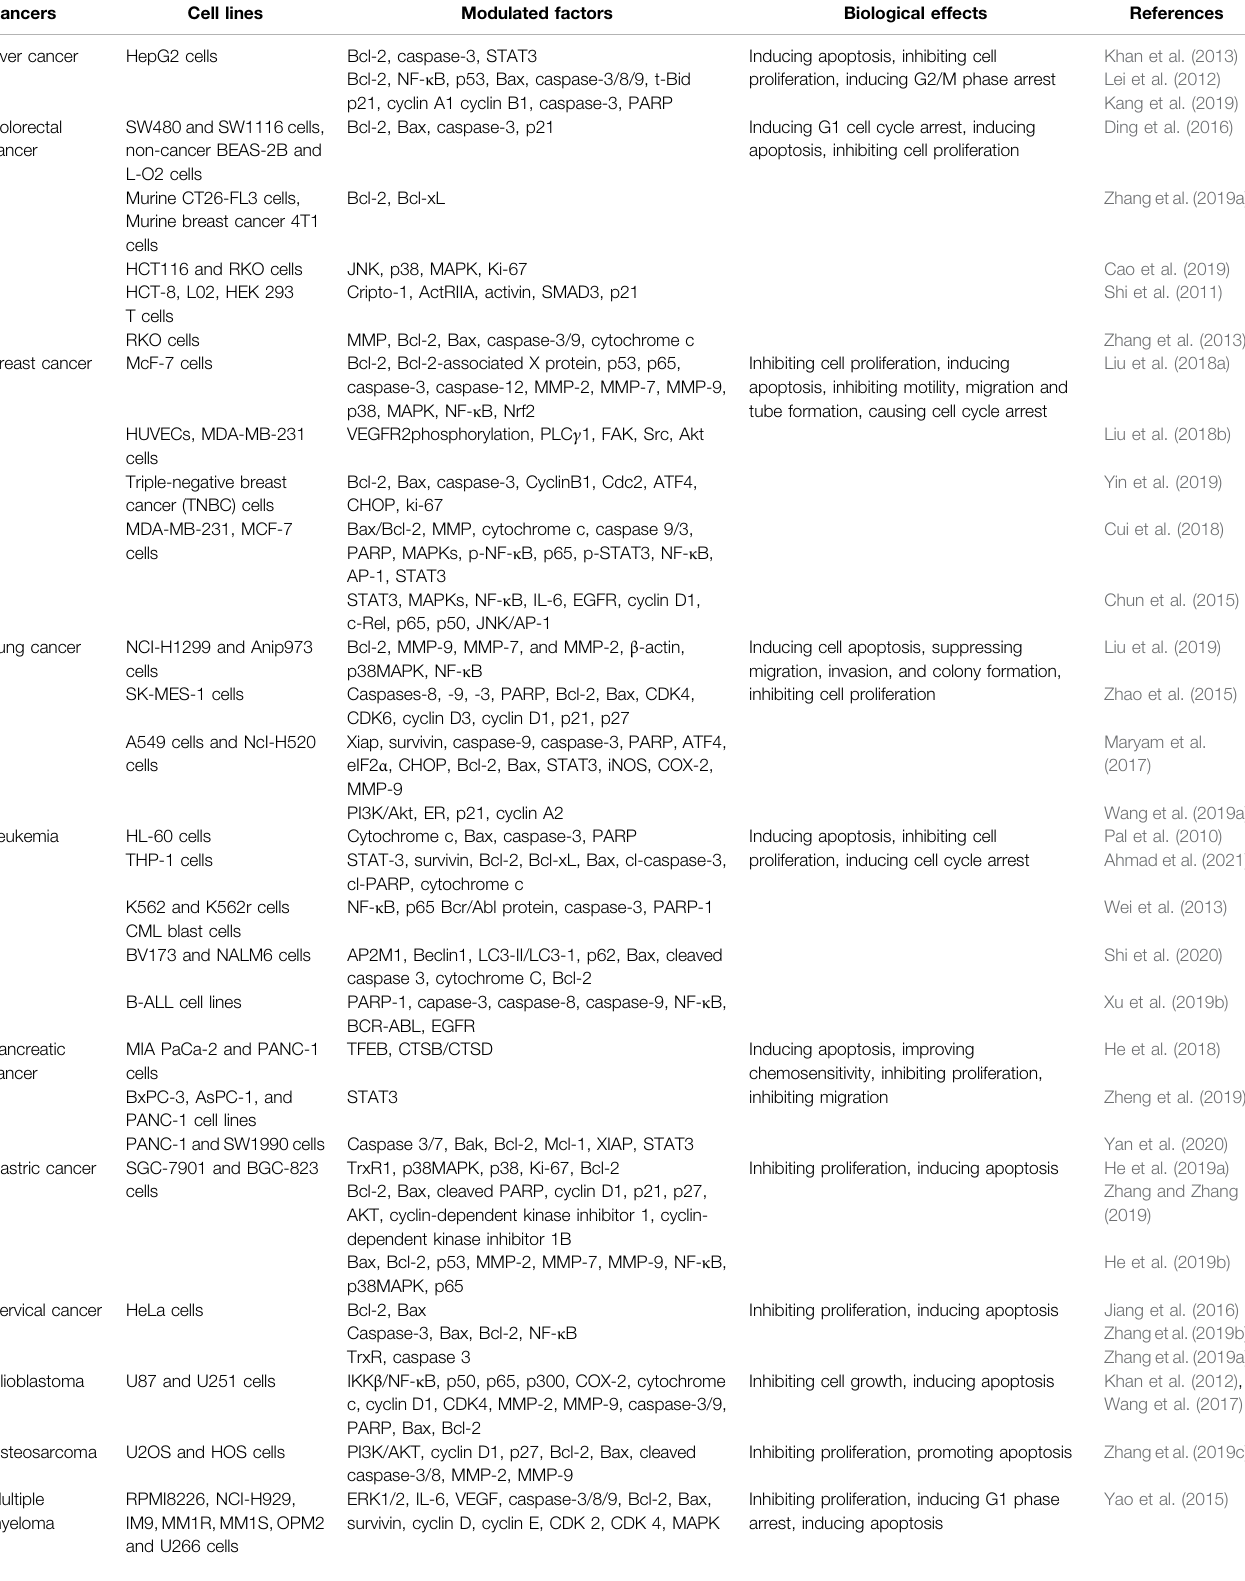
TABLE 1 | The anticancer activities and the underlying mechanisms of alantolactone in vitro .